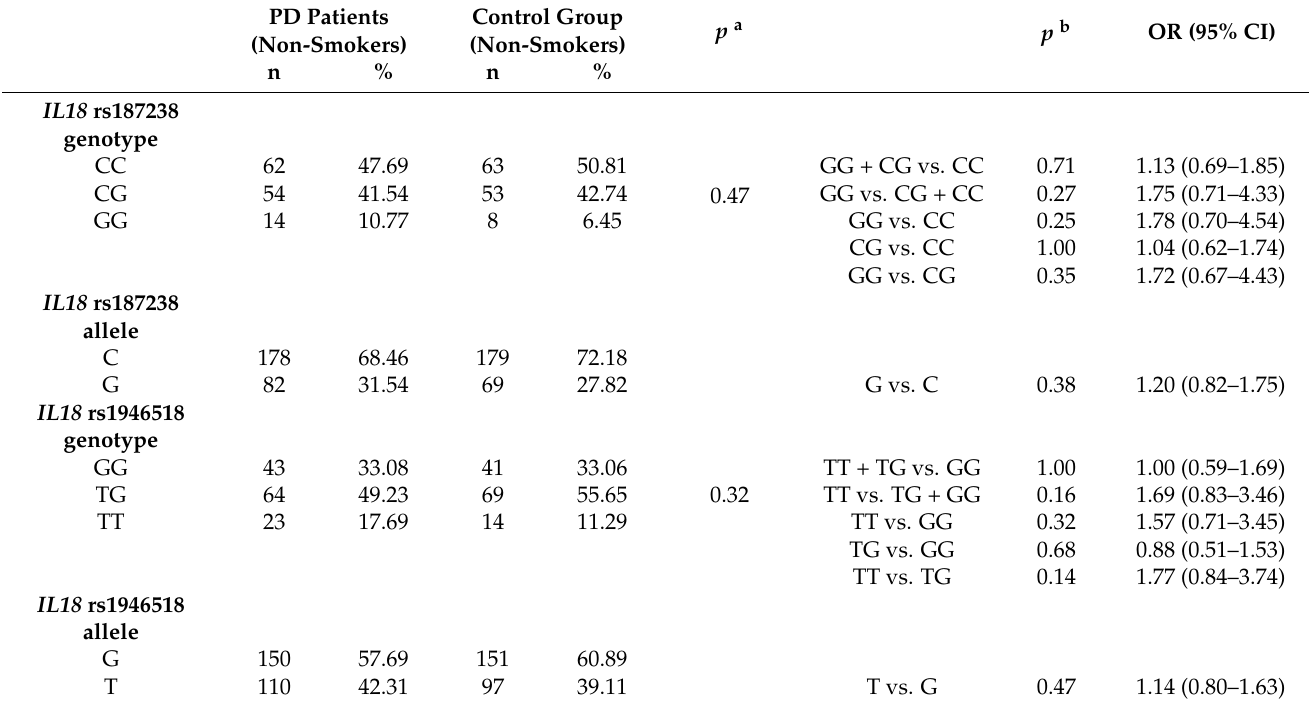
Table 3. The distribution of the IL-18 rs187238 and rs1946518 genotypes in periodontitis patients (PD patients) and the controls in the non-smoker